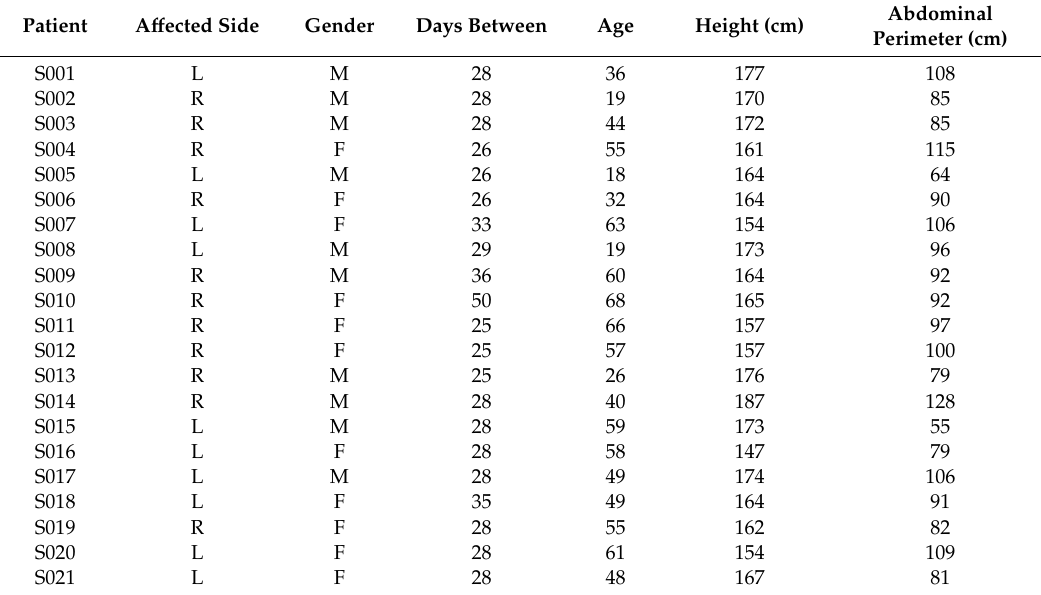
Table 1. Patient